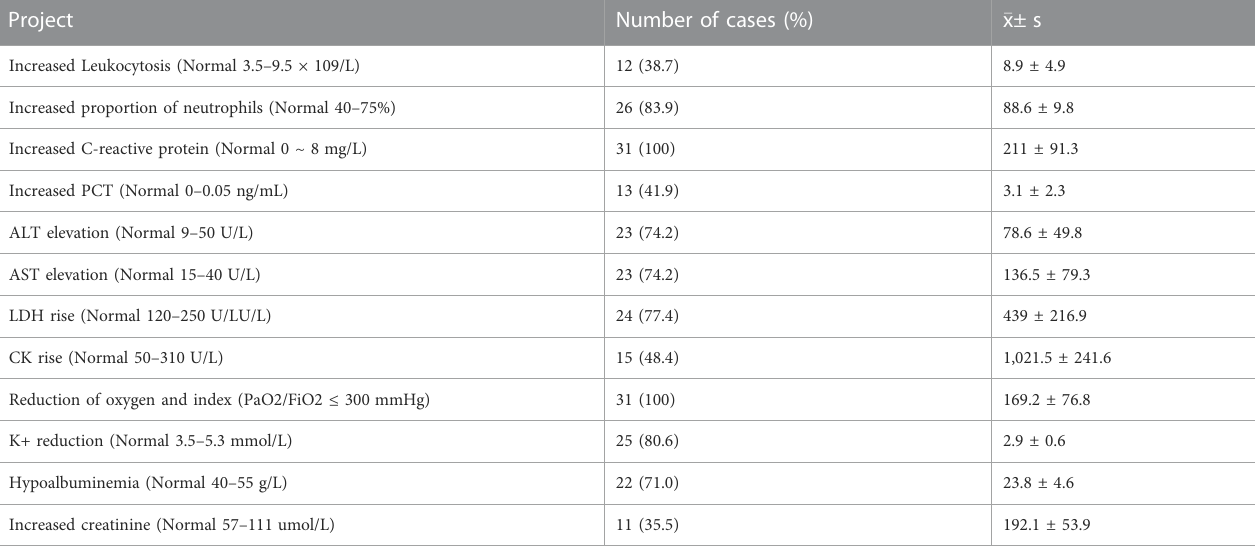
TABLE 3 Laboratory examination results of patients with C. psittaci